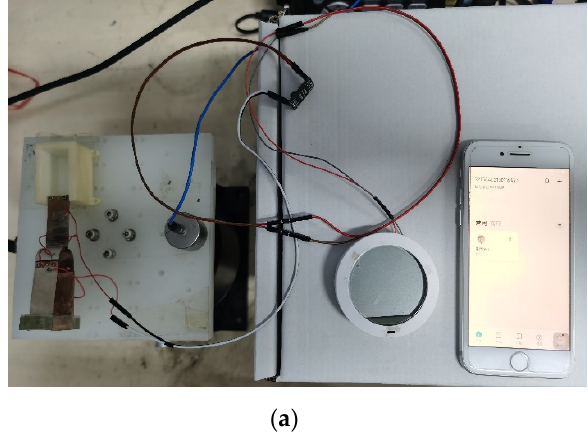
Figure 13. Charging behavior using LTC3588 ( 0.7g, 1.5cm a d = = ).